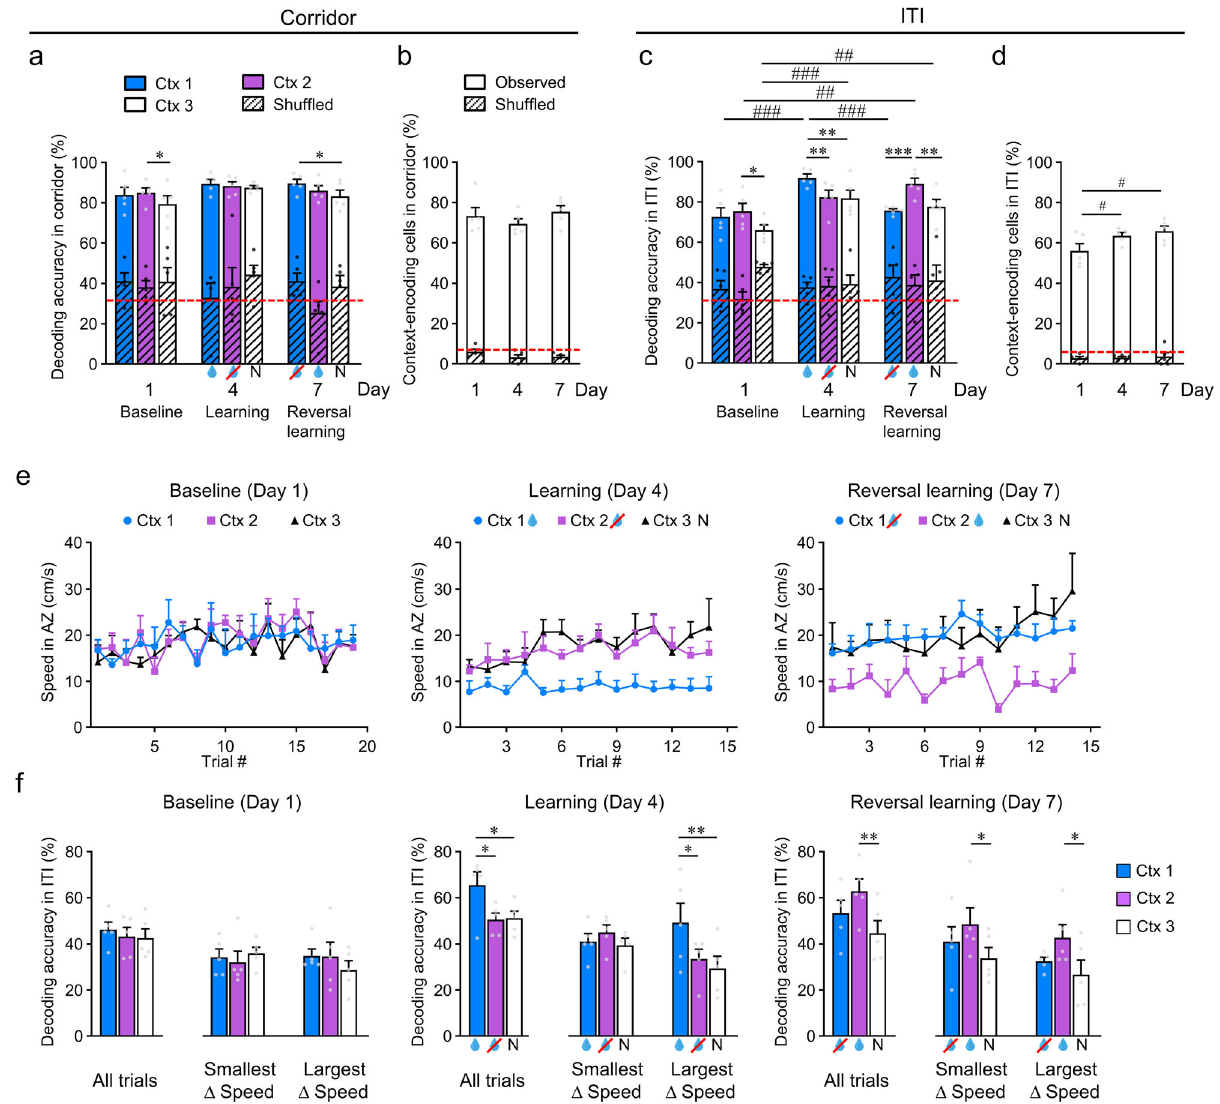
Fig. 3 Context-decoding accuracy during the intertrial interval (ITI) is higher for rewarded contexts across learning phases and shows intertrial variability correlating with within-session changes in running speed across contexts. a Decoding accuracy for each context along the virtual corridor (0 – 180 cm), across learning phases. Results after random shuf fl ing of the raw data (diagonal stripes) and red dashed line indicating the chance level (33.3%) are shown. b Proportion of context-encoding cells from responses along the virtual corridor across learning phases. c Same as a but during ITI. d Same as b but during ITI. e Within session trial-by-trial mean speed in the anticipation zone for each context across learning phases, averaged across animals. Rewarded context (blue drop), non-rewarded context (drop with red cross), and neutral context (N). f Decoding accuracy within the ITI after deconvolution across learning phases for all trials and for the two trials with the smallest and the two trials with the largest difference in speed between the rewarded and the non-rewarded context. For all, n = 5 mice and data are presented as mean values + SEM. For a – d and f , experimental data points are shown as gray dots and shuf fl ed data points are shown as black dots, two-way RM ANOVA and post-hoc Holm – Sidak tests were used, * p < 0.05, ** p < 0.01. Within-day comparisons: * p < 0.05, ** p < 0.01, *** p < 0.001; between-day comparisons: # p < 0.05, ## p < 0.01, ### p < 0.001. Exact p- values